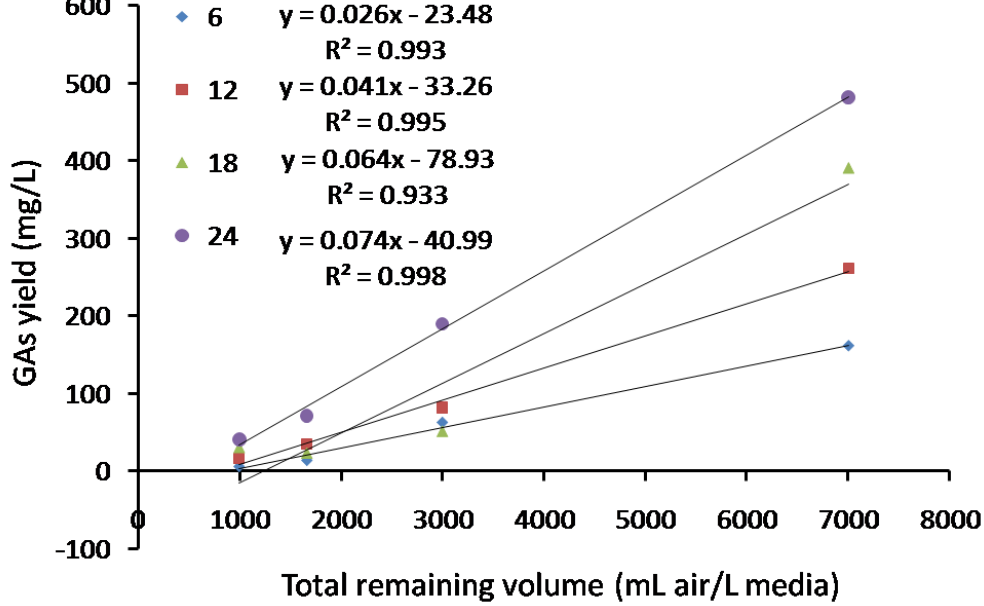
Figure 7. Linear regression analysis between GAs yield and total remaining volume of 1 L media in static culture container.